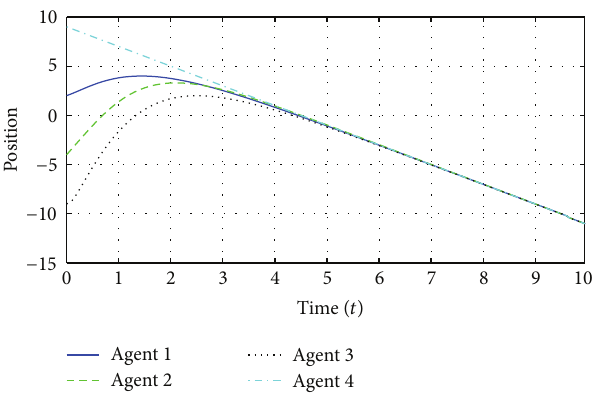
Figure 2: The evolution of position states 𝑥 𝑖 (𝑡) for 𝑖 = 1, ...,4